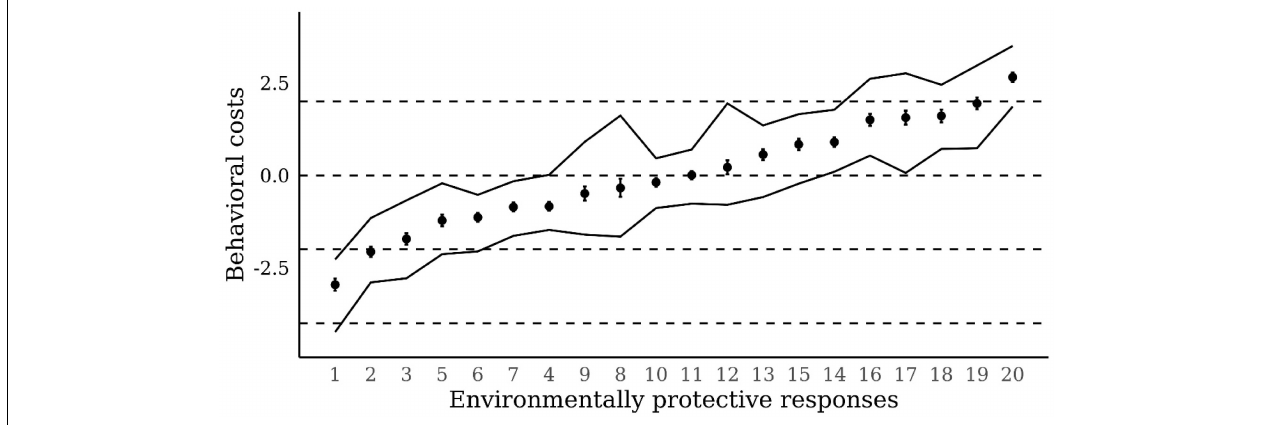
FIGURE 1 | Costs of providing environmentally protective responses. Cost estimates of providing environmentally protective responses and their 90% credible intervals are denoted by points and error bars. The area between the two solid lines denotes the range of country-specific variability in the costs of the 20 responses that were considered. The response numbers correspond with the item numbers in Supplementary Table 2